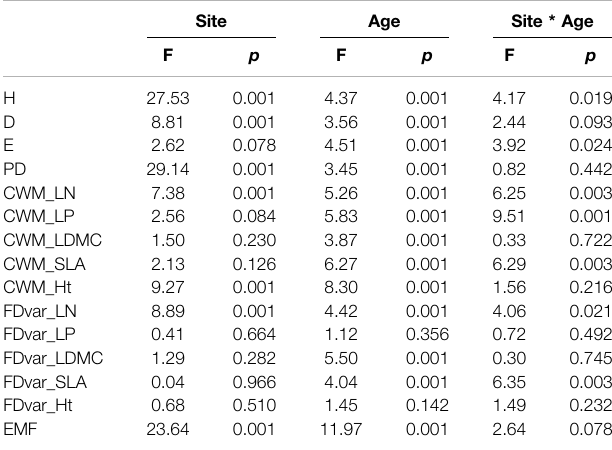
TABLE 2 | Results of two-way ANOVA for comparing diversity indices and EMF over stand age among four sites.